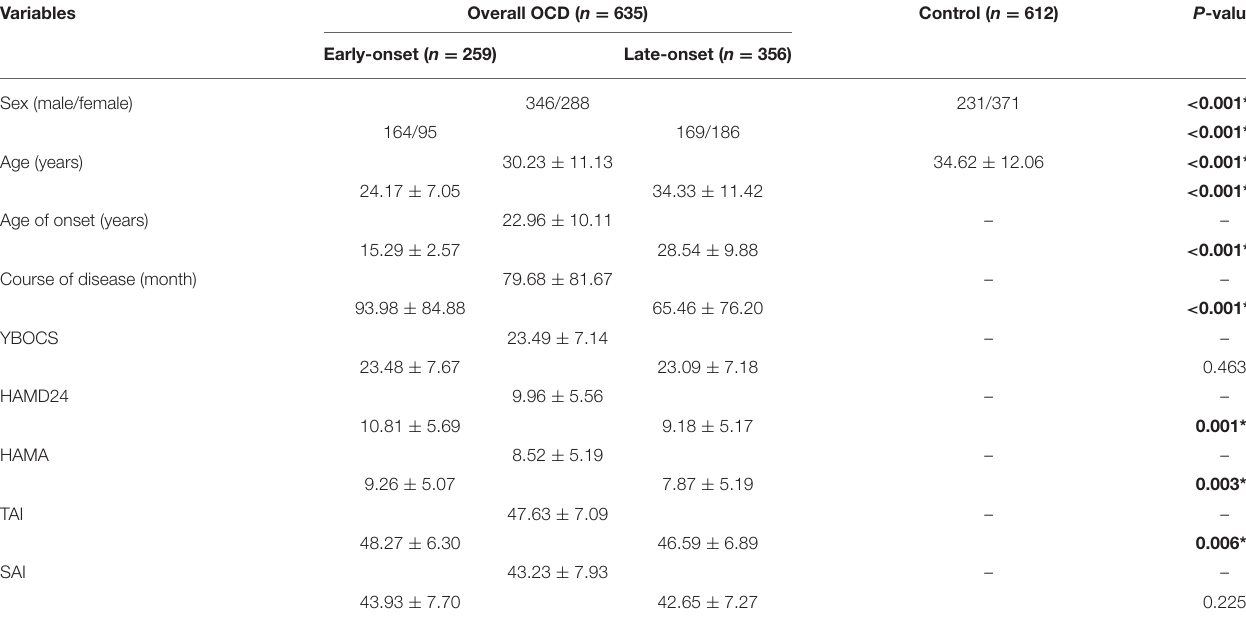
TABLE 1 | Socio-demographic and clinical characteristics (Means ± SD).